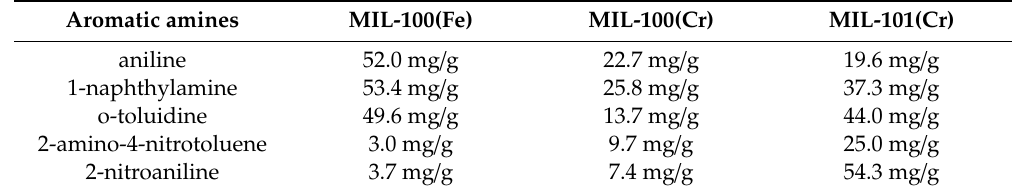
Table 3. Saturated adsorption capacity (mg / g) of aromatic amines by MIL-100(Fe, Cr) and MIL-101 (Cr). Aromatic